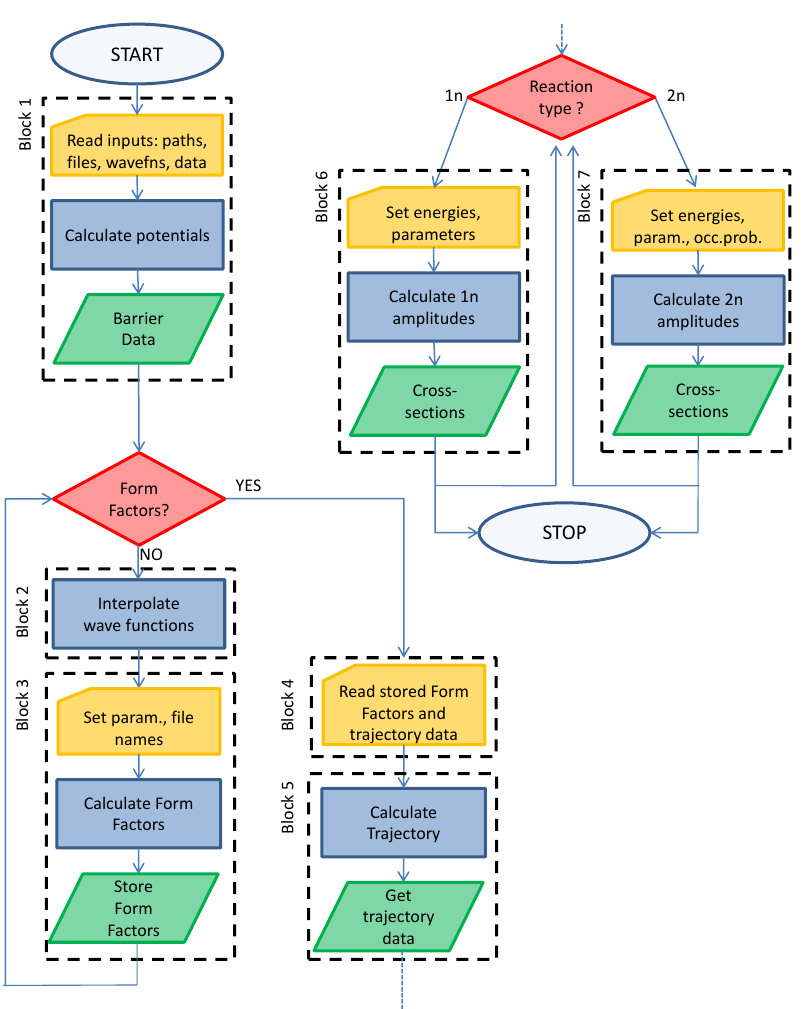
Figure 1. Flowchart diagram of the code. Blocks (corresponding to groups of cells) are indicated with dashed black boxes. Inside each block, data reading is indicated as yellow cards, algorithms are indicated as blue rectangles and outputs as green parallelograms. Red rhombi define decisional branching points. Notice that Blocks 2 and 3 can be skipped when form factors are already known (i.e., when Block 2 plus Block 3 have been successfully run in a previous